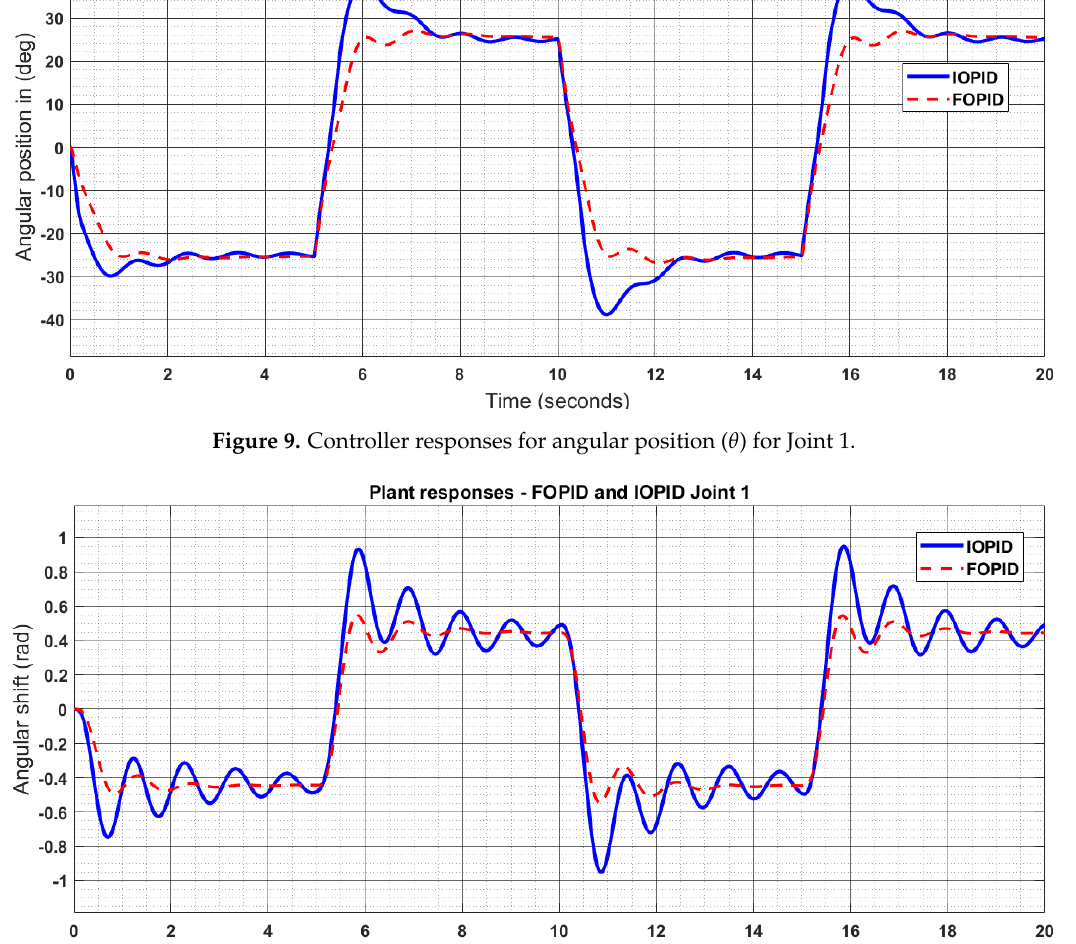
Figure 10. Controller responses for angular shift ( φ ) for Joint